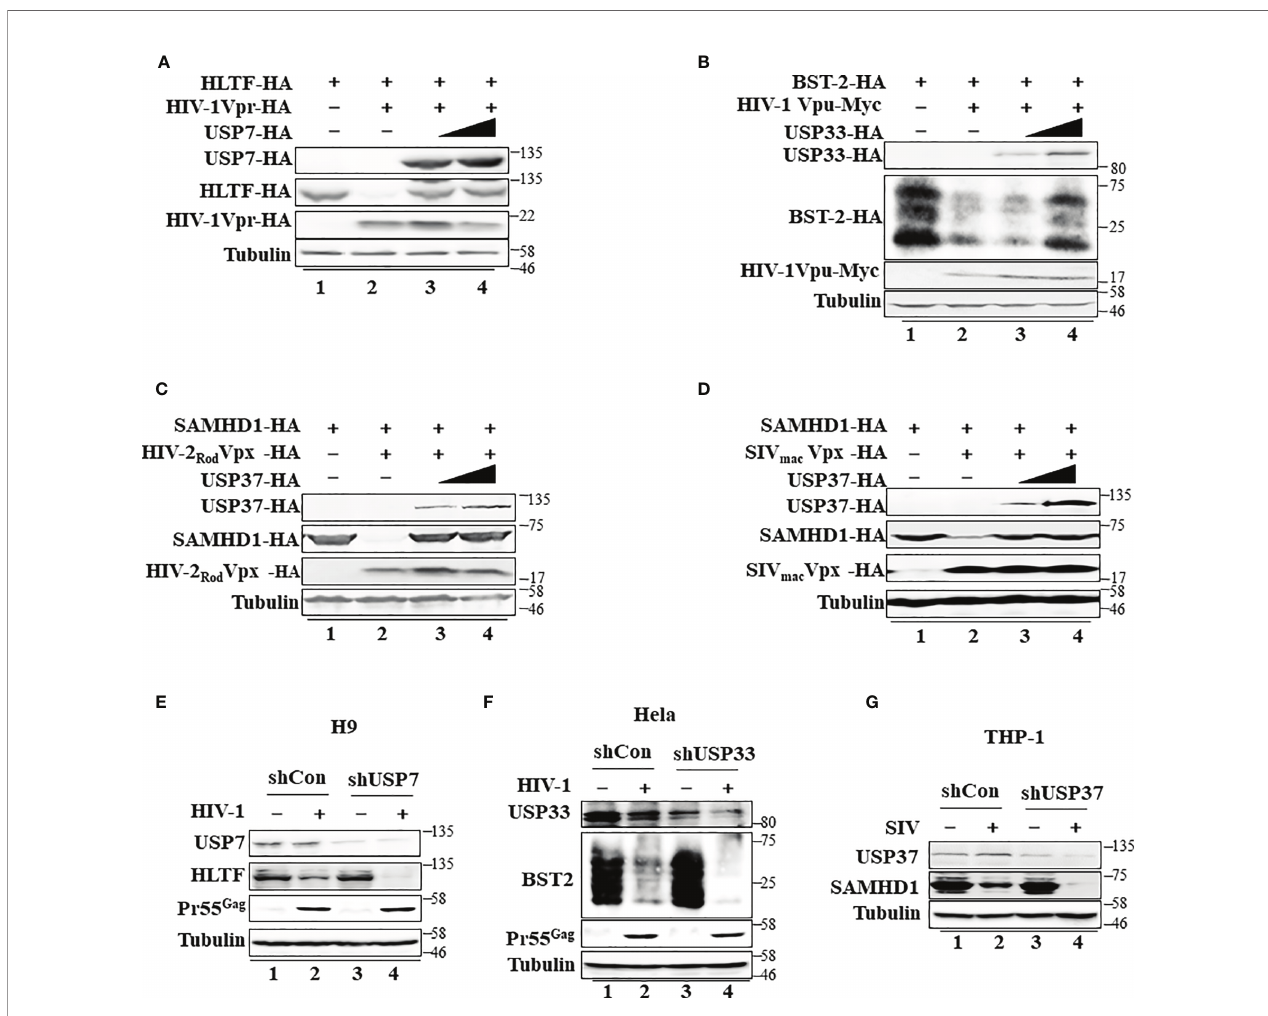
FIGURE 5 | Speci fi c deubiquitinating enzymes suppress degradation of host restriction factors mediated by HIV/simian immunode fi ciency virus (SIV) proteins. (A) Ubiquitin-speci fi c protease 7 (USP7) inhibits HIV-1 Vpr-induced degradation of HLTF. HEK293T cells were transfected with expression vectors as indicated. Cell lysates were immunoblotted with the corresponding antibodies. (B) USP33 inhibits HIV-1 Vpu-induced BST-2 degradation. The experimental methods were the same as in panel (A). (C, D) USP37 inhibits HIV-2 Rod Vpx- (C) or SIV mac Vpx (D) -induced SAMHD1 degradation. The experimental methods were the same as in panel (A). (E) The effect of USP7 silencing on HLTF expression in WT HIV-1-infected H9 cell. H9 shUSP7 and its control cell lines were infected with WT HIV-1 or not for 48 h. Endogenous USP7 and HLTF were analyzed by immunoblotting. Virus infection was determined by Pr55Gag. (F) The effect of USP33 silencing on BST2 expression in WT HIV-infected Hela cell. The process is described in panel (E). (G) The effect of USP33 silencing on SAMHD1 expression in SIVmac-GFP-infected THP-1 cell. THP-1 cells stably expressed USP33shRNA. USP33 knockdown THP-1 cells were differentiated into macrophages by phorbol 12-myristate 13-acetate (PMA) treatment and infected with SIV mac viruses for 24 h. Endogenous USP33 and SAMHD1 were analyzed by immunoblotting. Immunoblotting results are representative of n = 3 independent